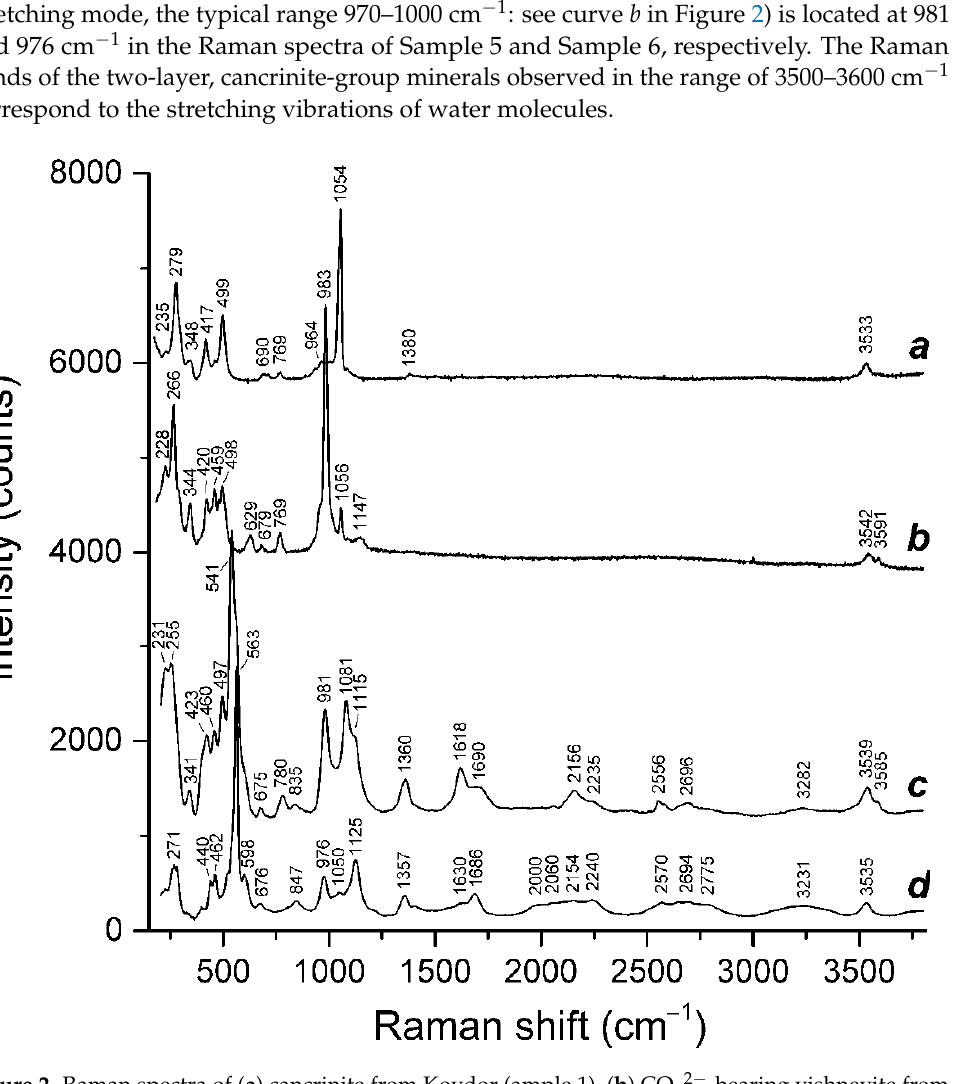
Figure 2. Raman spectra of ( a ) cancrinite from Kovdor (ample 1), ( b ) CO 32– -bearing vishnevite from Loch Borrolan (Sample 4), ( c ) kyanoxalite from Alluaiv (Sample 5) and ( d ) kyanoxalite from Flora (Sample 6).